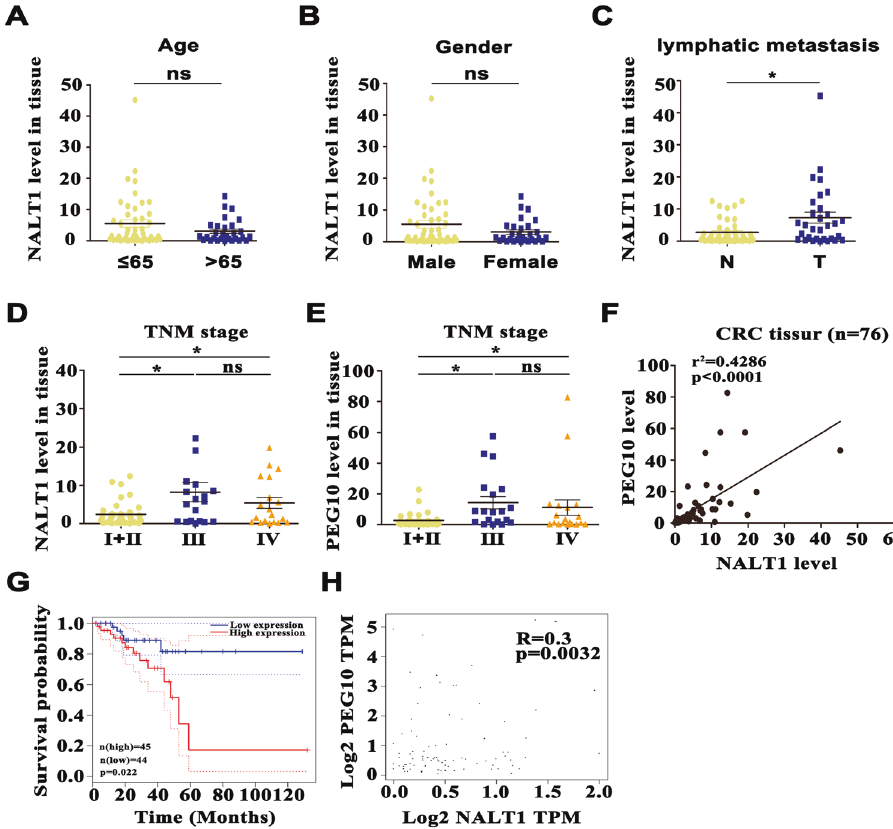
Fig. 8 NALT1 may serve as a promising prognostic biomarker for CRC. A – E Predictive value of NALT1 tissue expression in clinicopathological features based on the CRC cohort ( n = 76). F Tissue expression of NALT1 was associated with that of PEG10 in the CRC cohort ( n = 76). Mean ± SD. Student ’ s t test or ANOVA. * p < 0.05; ns not signi fi cant. G Patients with rectum adenocarcinoma with high PEG10 expression survived shorter than those with low PEG10 expression in the GEPIA database. H The expression of NALT1 was associated with that of PEG10 in the CRC cohort in the GEPIA